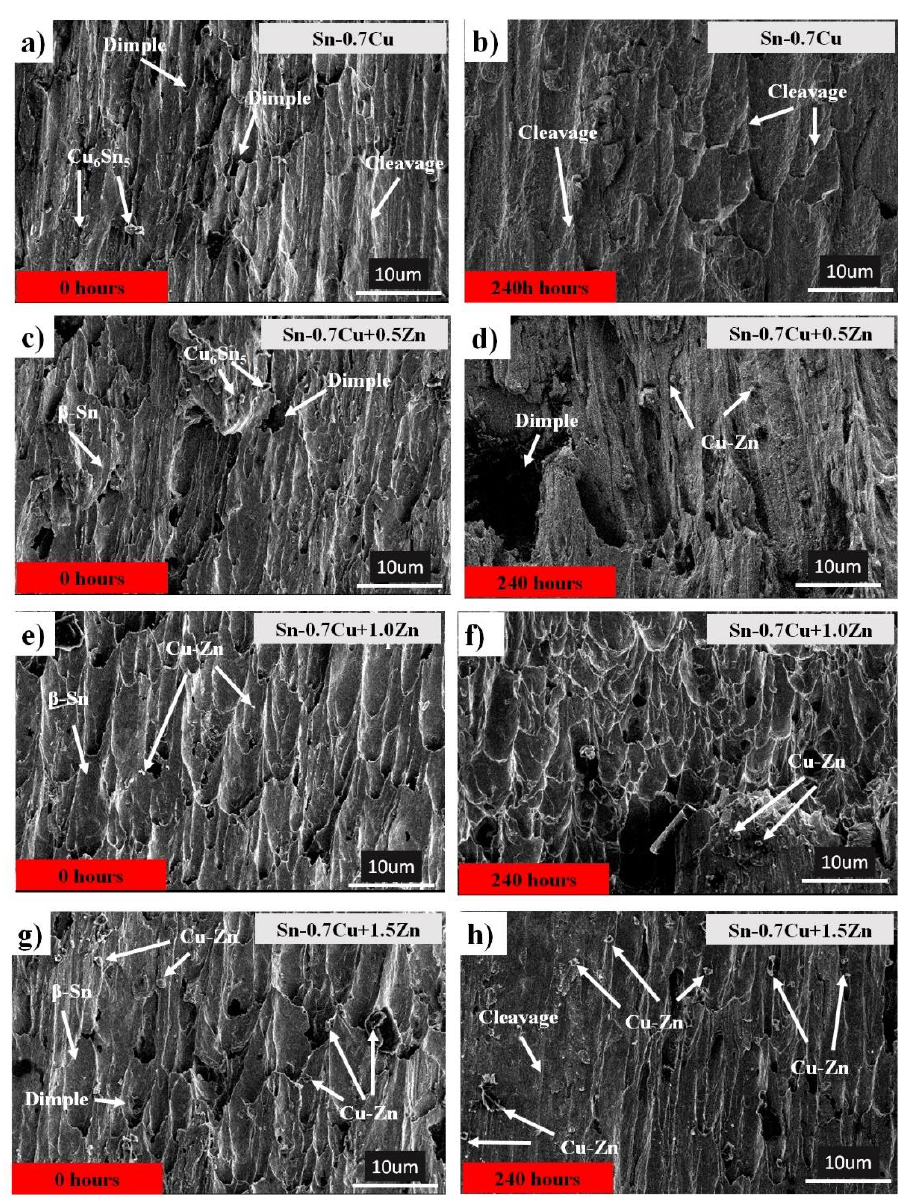
Figure 16. Fractographies of ( a , b ) Sn-0.7Cu, ( c , d ) Sn-0.7Cu-0.5Zn, ( e , f ) Sn-0.7Cu-1.0Zn and, ( g , h ) Sn-0.7Cu-1.5Zn.